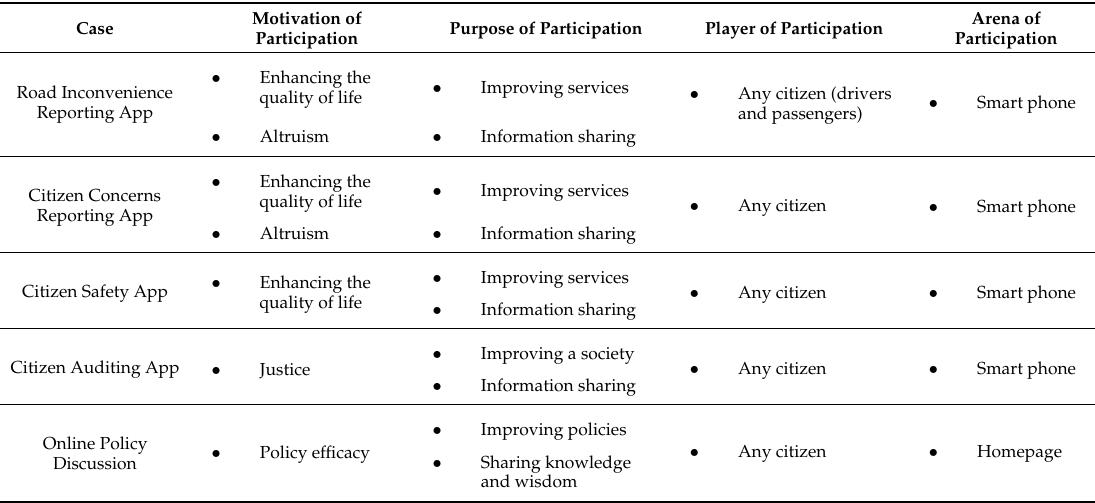
Table 4. Cases of citizen-government